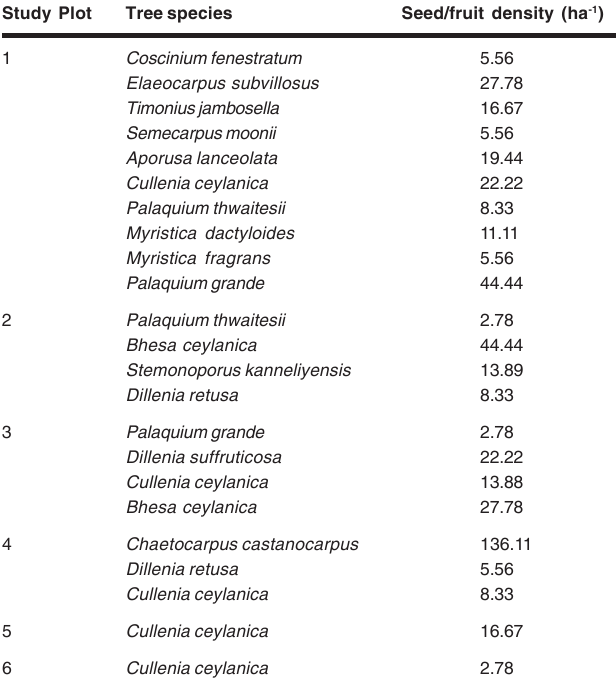
Table 4. Density of seeds/fruits found on the floor of each of the six plots in the Kanneliya